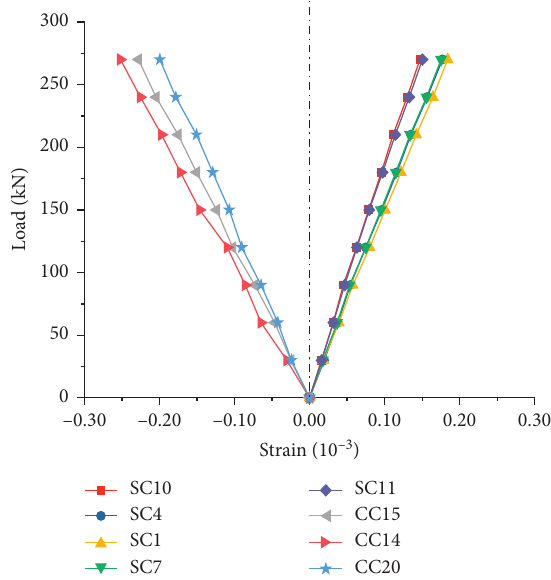
Figure 15: Load-strain relationship of SC-M1 in flexural